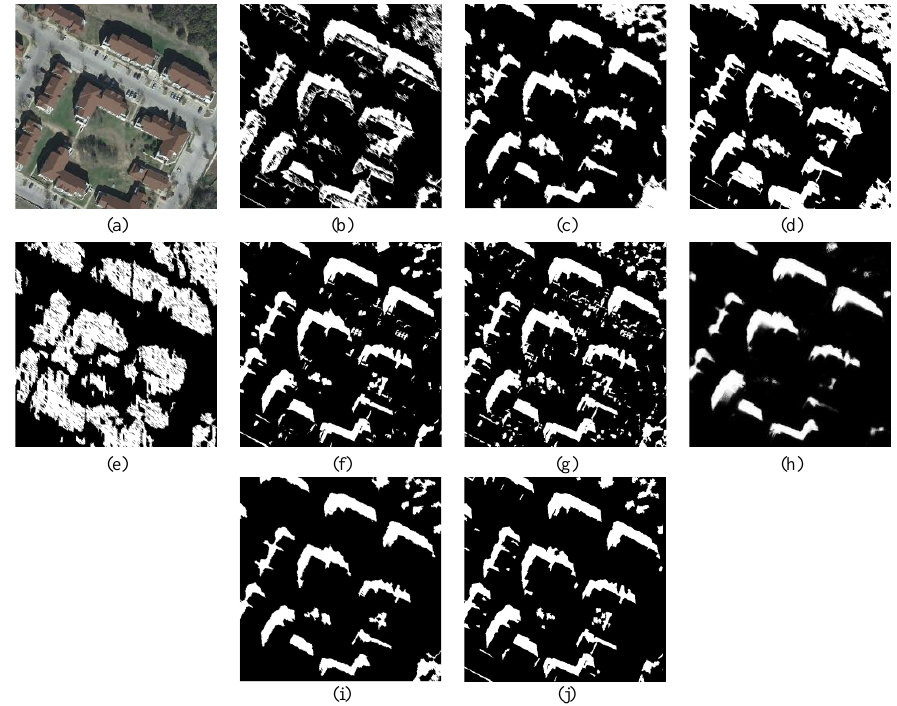
Figure 5. ( a ) Original image; ( b ) SRHI; ( c ) NB; ( d ) HTD; ( e ) C1C2C3; ( f ) U-Net method; ( g ) Segnet method; ( h ) BDRAR method; ( i ) DLA-PSO method; ( j ) ground truth. Table 2. Austin shadow-test-evaluation index.